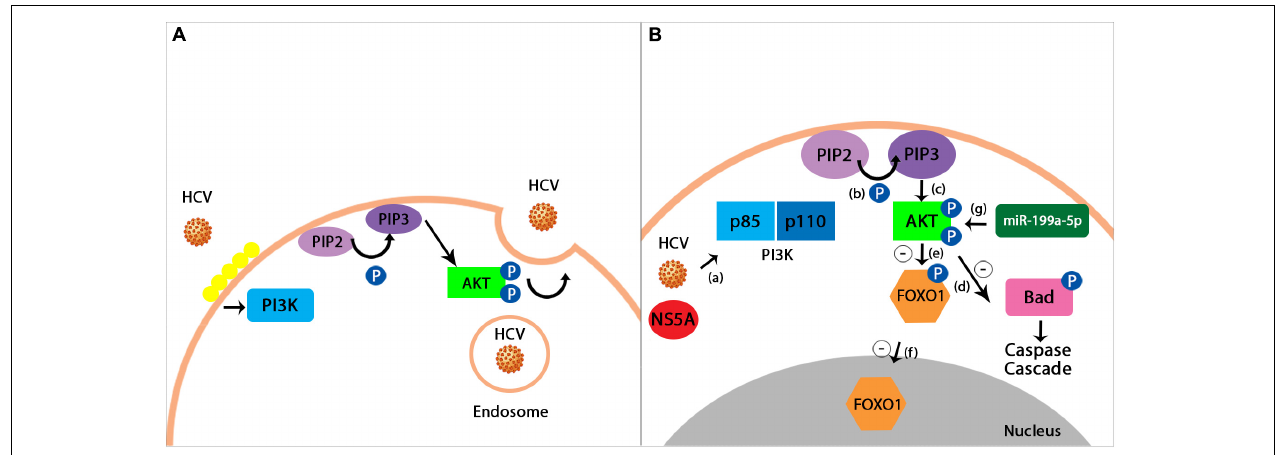
FIGURE 2 | (A) HCV entrance into the host cell using PI3K/Akt pathway. Hepatitis C virus uses a pH-dependent way in order to enter the intracellular environment of the host. The virus causes the lipids on the cellular surface to cluster (depicted in the figure through a yellow lining of the membrane), thus triggering the process of endocytosis mediated by the PI3K/Akt signaling pathway (Diehl and Schaal, 2013). (B) miR-199a-5p proposed effect on PI3K/Akt pathway during HCV infection. HCV infection activates the PI3K member of the signaling pathway with the help of a viral protein known as Non-structural protein 5A (NS5A) (a) . PI3K is